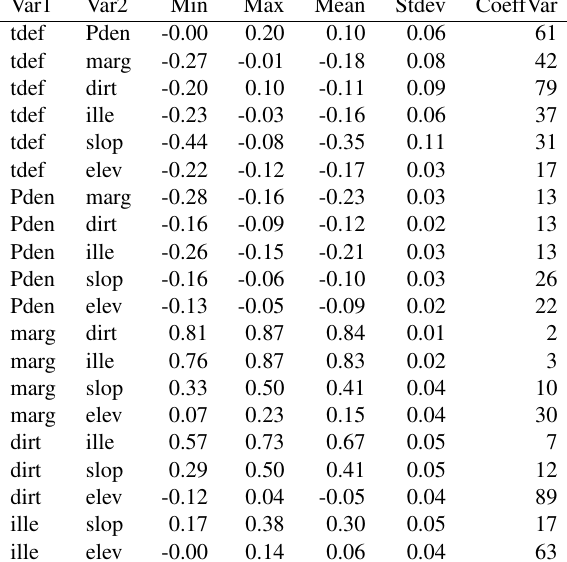
Table 6: Minimum, maximum, mean, standard deviation and co- efficient of variation of the values of the Pearson coefficient